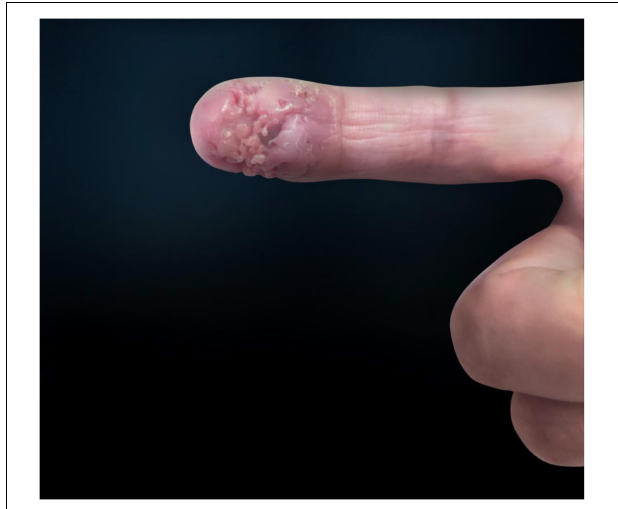
FIGURE 1 | Ulceration with a stalactite appearance at the distal end of the index finger.